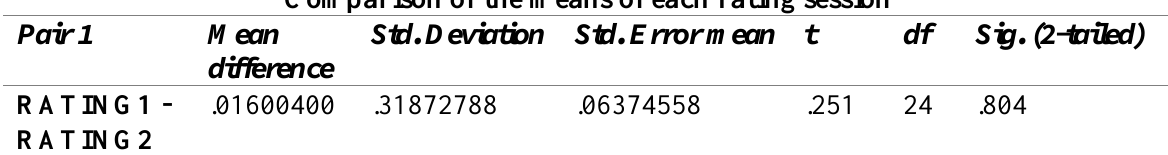
Comparison of the means of each rating